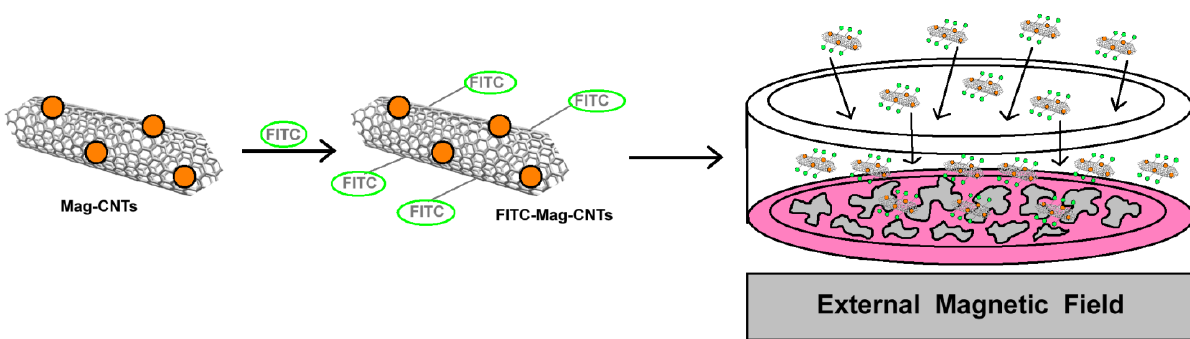
Figure 17. Magnetic field driven magnetic CNTs into HSPCs. Once the magnetic nanosystem has been assembled, the incubation with cells aided by an external magnetic field, improves the transfection